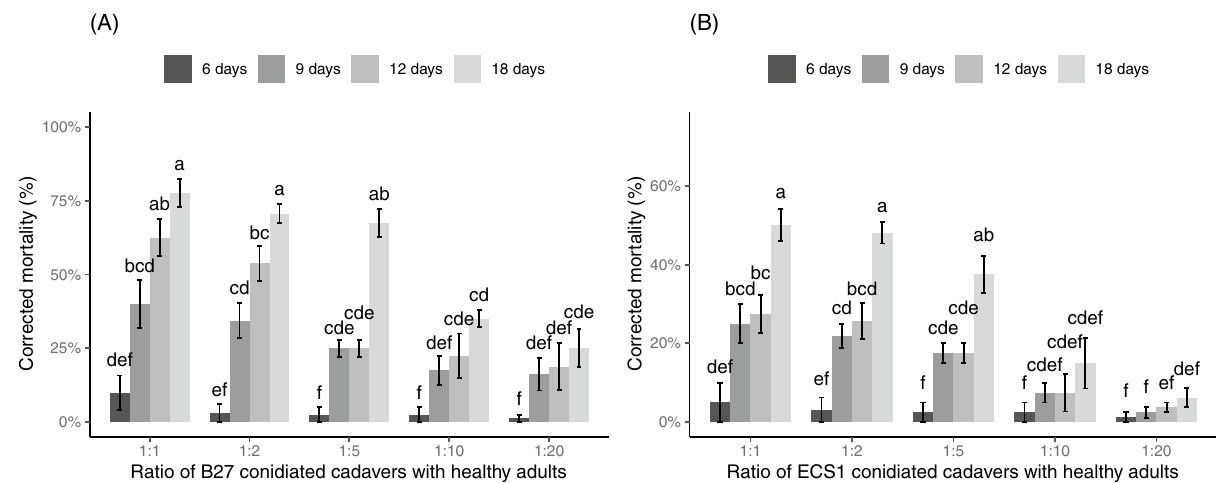
Figure 3. The mortality of healthy adult weevils at 6 days, 9 days 12 days and 18 days post-introduction of ( A ) B27 conidiated cadaver and ( B ) ECS1 conidiated cadaver at different ratios inside an insect cage. Results of multifactorial “F1-LD-F1” non-parametric analyses: ( A ) Wald-type statistics (WTS) = 45.42, df = 4, P < 0.001 (for ratios), WTS = 413.89, df = 3, P < 0.001 (for measured times), WTS = 72.66, df = 12, P < 0.001 (for interactions), ( B ) WTS = 135.16, df = 4, P < 0.001 (for ratios), WTS = 107.64, df = 3, P < 0.001 (for measured times), WTS = 97.11, df = 12, P < 0.001 (for interactions). Columns with different letters are significantly different from each other (pairwise Wilcoxon rank-sum test, P < 0.05). ( A , B ) were analysed separately. Error bars represent standard